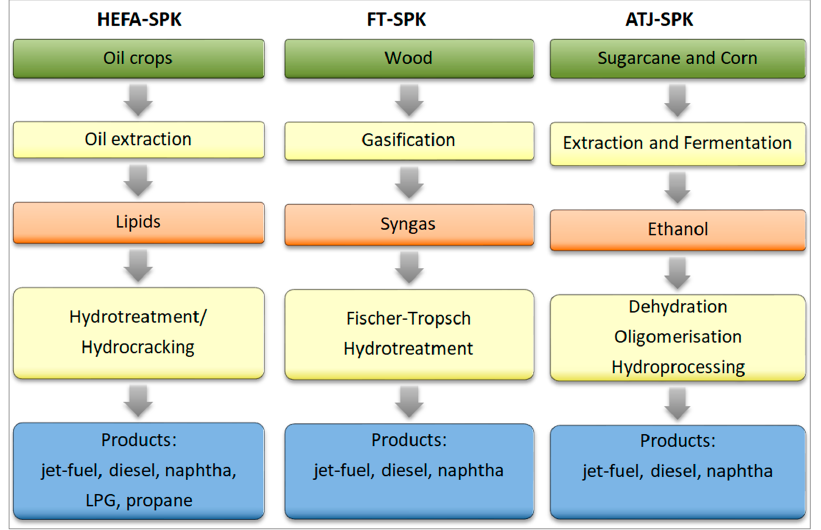
Figure 1. Scheme of the three SAF production routes considered. Sources: based on references